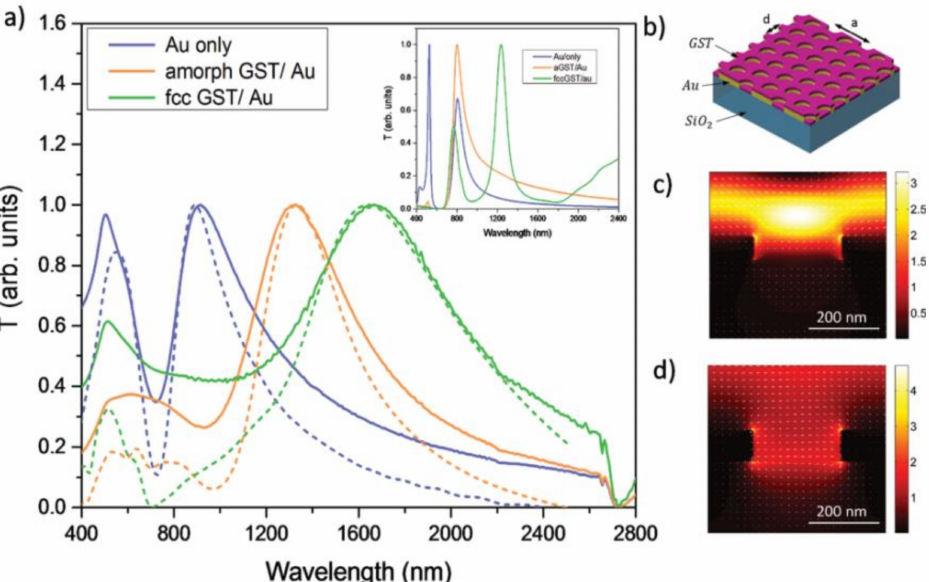
Figure 13. The GST-integrated fishnet metasurfaces constructed by a circular holes array for actively tunable EOT [114]; ( a ) transmission spectra with moveable peaks of EOT for plasmonic resonance by bare metallic hole and the other two with amorphous and crystalline GST on top; ( b ) the device setup; ( c , d ) the field distribution for ( c ) off-resonance and ( d ) on-resonance mode—all figures are reproduced with permission from